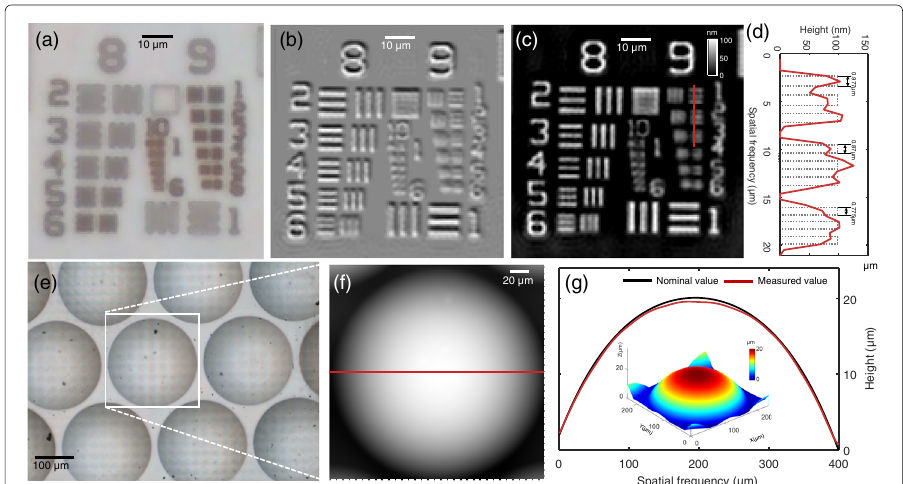
Fig. 24 Experiment for imaging resolution verification by standard phase resolution targets QPT TM and microlens array. (a) Bright field image of QPT TM . (b) Phase gradient image obtained by DPC. (c) Reconstructed quantitative phase. (d) Quantitative profile along the red line in (c). (e) Bright field image of the microlens array. (f) Reconstructed quantitative phase of a selected microlens element. (g) Comparison of